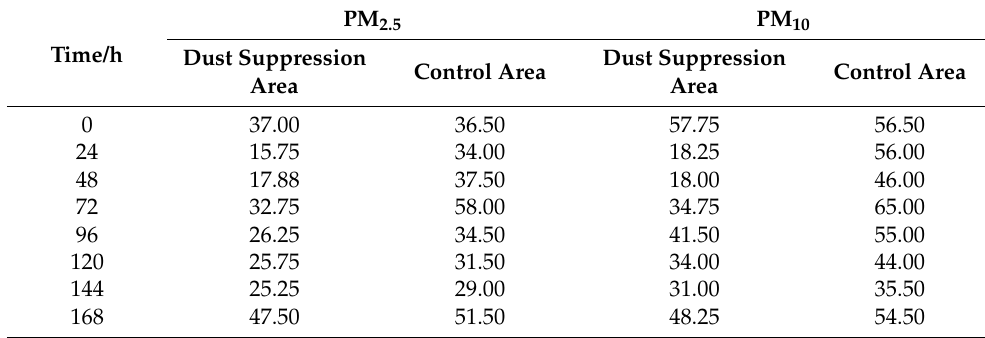
Table 6. Concentration of suspended particles at the dust suppression site ( µ g/m 3 ).